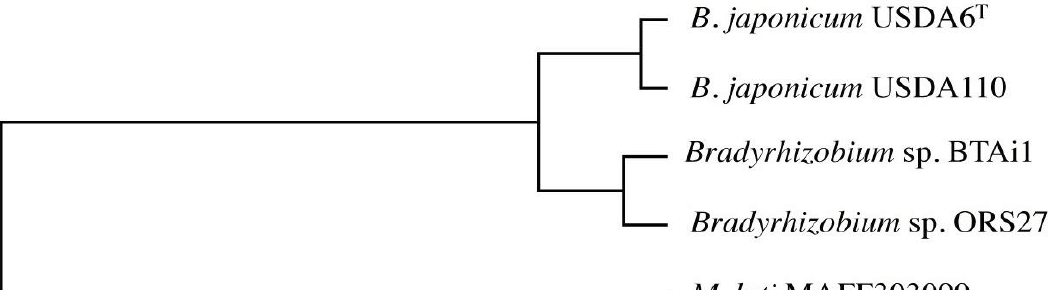
Figure 2. A typical phylogenetic tree using orthologous genes with a single linkage